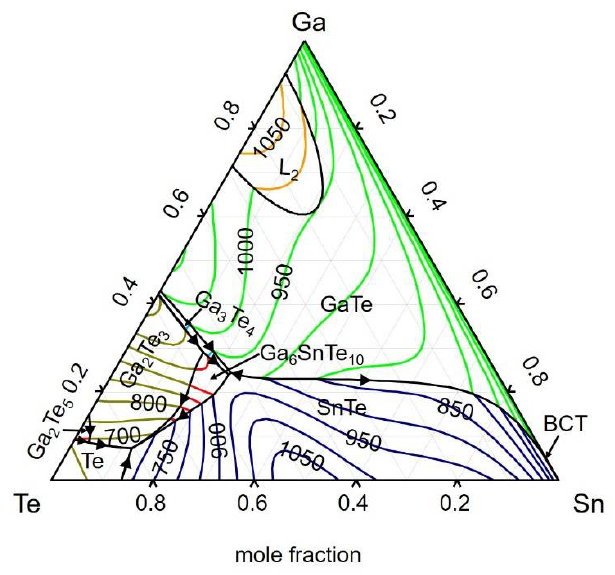
Figure 9. Calculated liquidus projection in the Ga-Sn-Te system. Table 3. Invariant reactions in Ga-Sn-Te system. Sr. No.